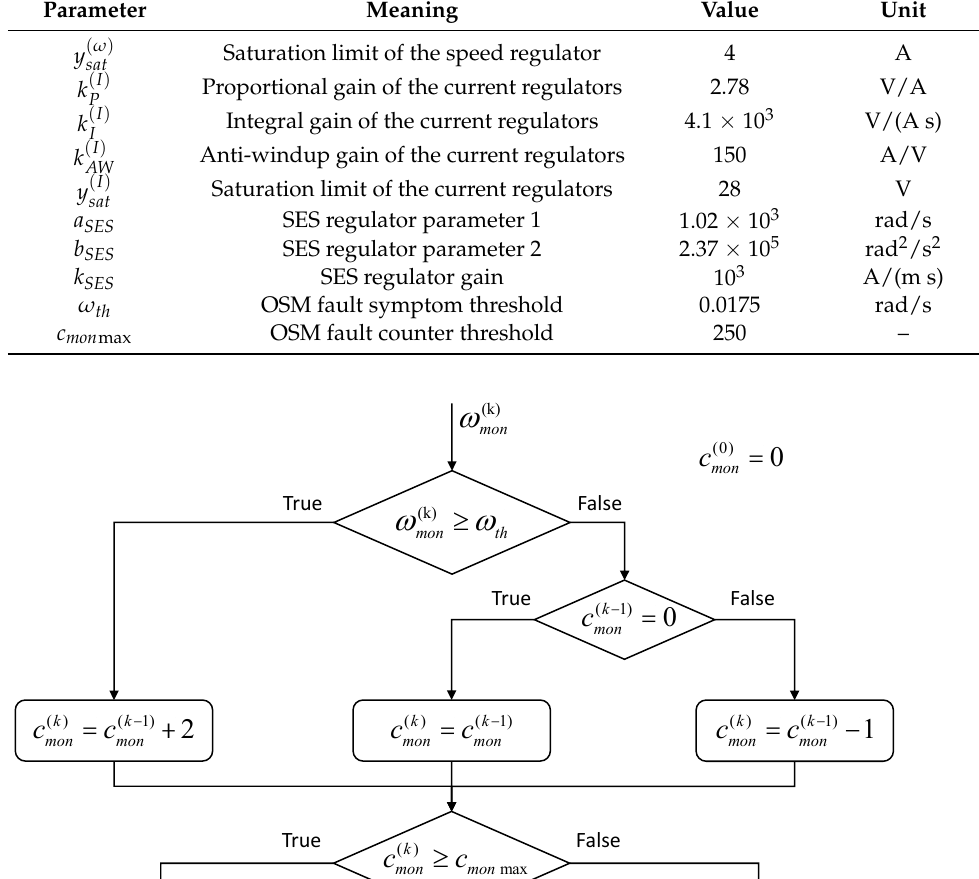
Figure 9. Fault detection logics of the OSM.